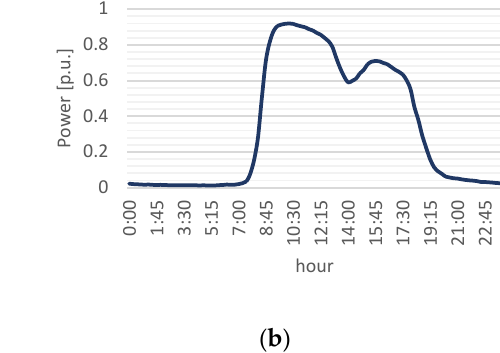
Figure 5. “M-type profile” obtained in industrial clients I1 and I2 (L) and commercial clients C1 and C2 (L). ( a ) The left curve corresponds to an industrial customer, and ( b ) the right curve corresponds to a commercial customer.